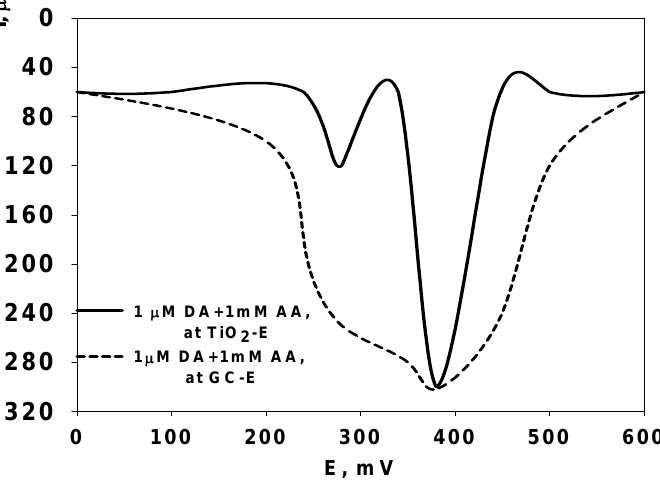
Figure 1. Differential pulse voltammogram of 1  M DA in 1 mM AA solution, in 0.1 M phosphate buffer, pH 7.4; at GCE (dashed line) and at TiO (continous